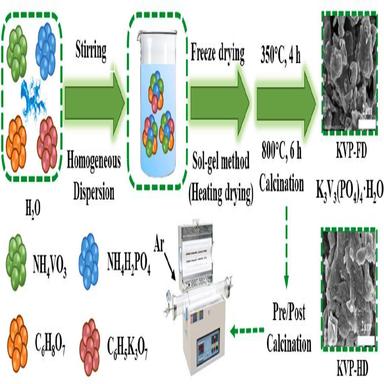
Schematic illustration of the preparation of KVP-FD and KVP-HD materials via freeze-drying and sol–gel heating drying with subsequent calcination.